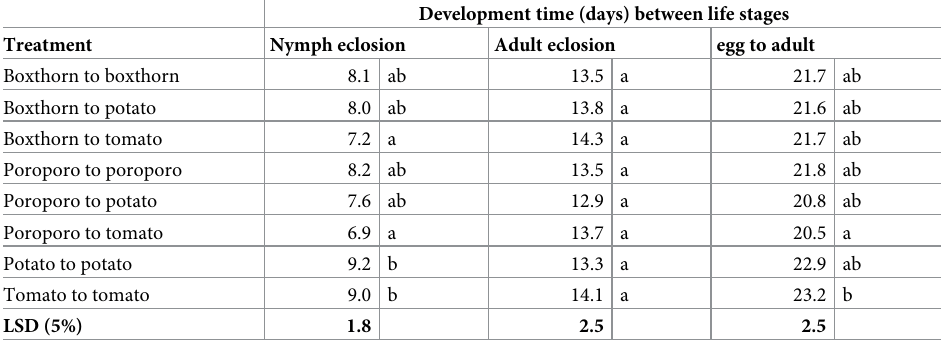
Table 2. Development time (days) between life stages of tomato potato psyllid progeny from adults originating from the same or different host plant species. Within a column, means (n = 6) with a letter in common within a col- umn did not differ significantly on the basis of an unrestricted 5%-level LSD